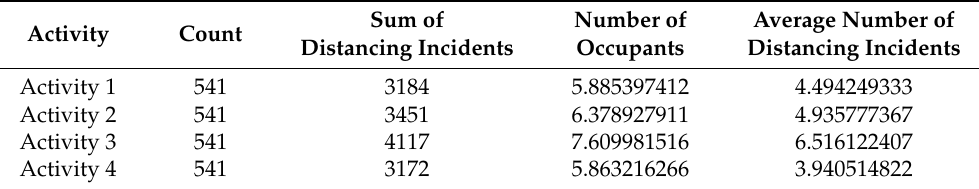
Table 5. Summary of ANOVA analysis for simulated occupancy for four typical teaching and learning activities in the same room, with contact time consideration.